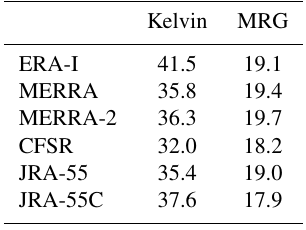
Table 2. Percentage of variance explained by the leading EOF pairs representing Kelvin and MRG waves for each